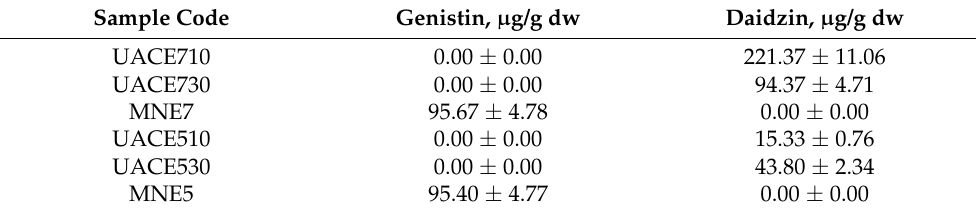
Table 4. Isoflavone glycosides genistin and daidzin yields ( µ g/g) found in samples treated by acid